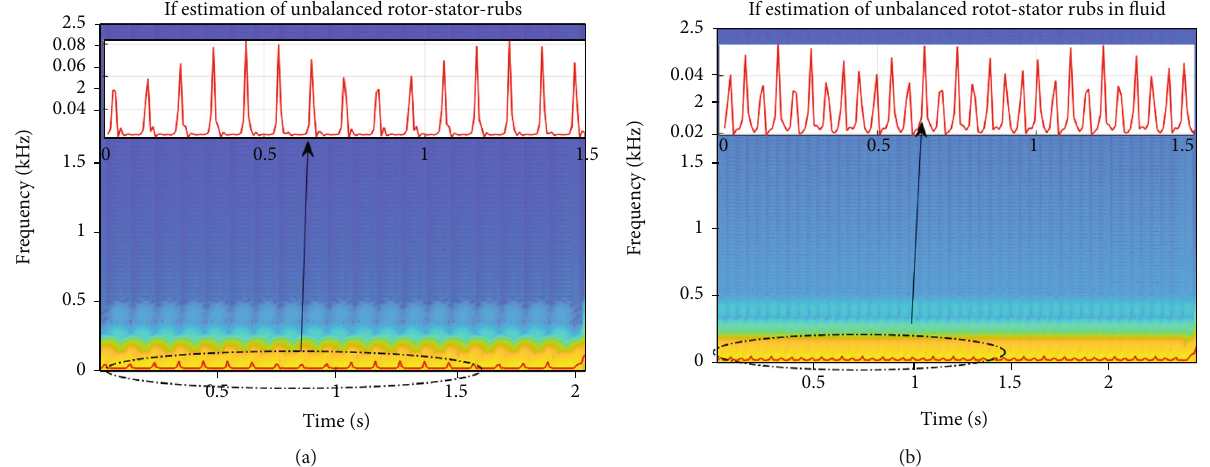
Figure 12: IF estimation of the dynamic response using the lateral rotor system. (a) In air and (b) fl uid